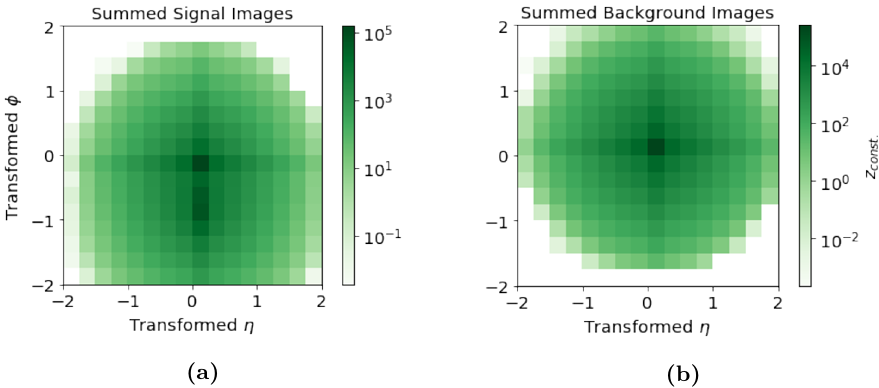
Figure 4. Toy model summed input images for signal (a) and background (b) jets.